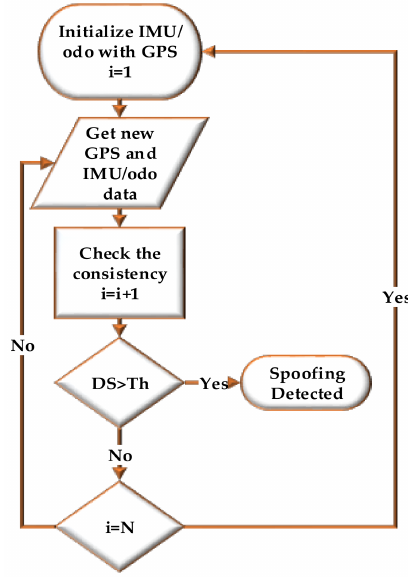
Figure 1. Operational flowchart of the proposed